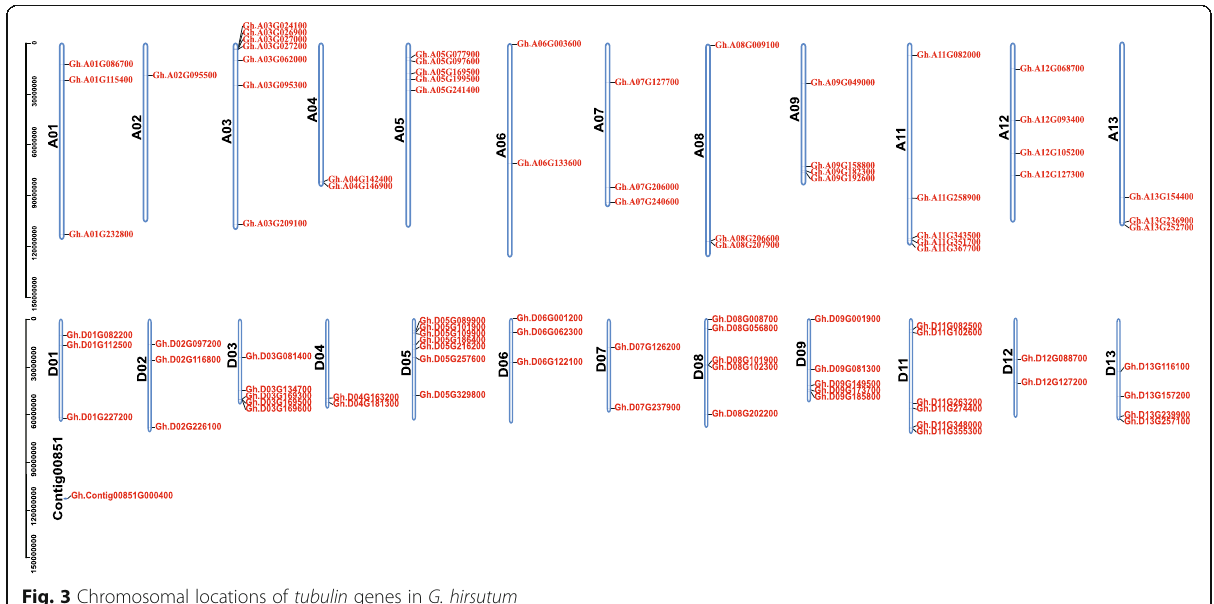
Fig. 3 Chromosomal locations of tubulin genes in G.